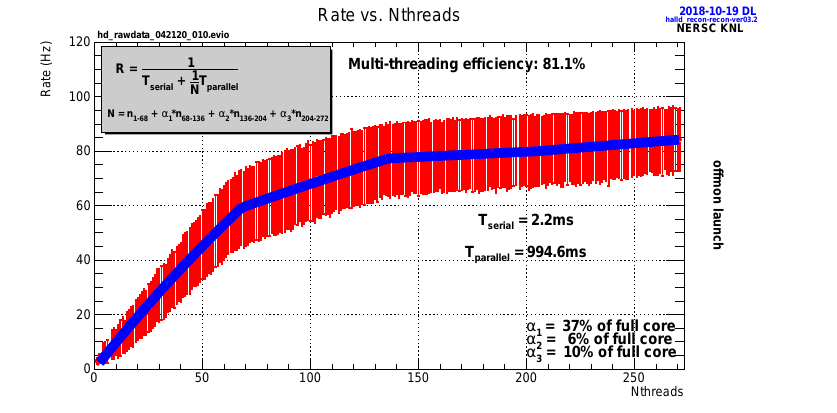
Figure 2. Thread scaling for NERSC job on Cori II (KNL).